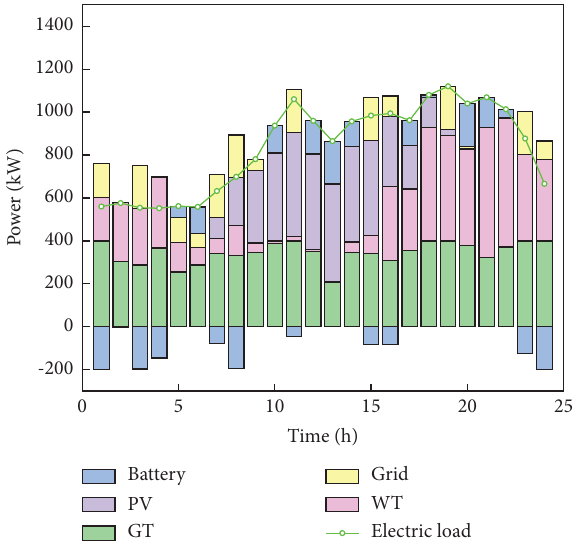
Figure 12: Electricity output optimal results of the PIES.